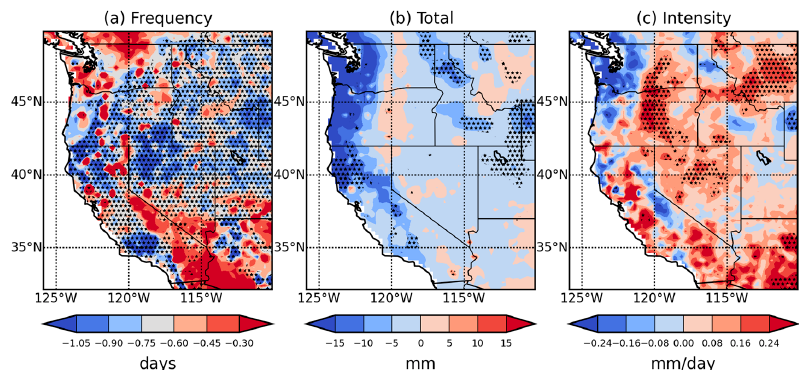
Figure 4. The total change in the winter season precipitation ( a ) frequency, ( b ) seasonal total, and ( c ) mean daily intensity over the western United States between 1999 and 2016. The hatches indicate where the changes are statistically significant.